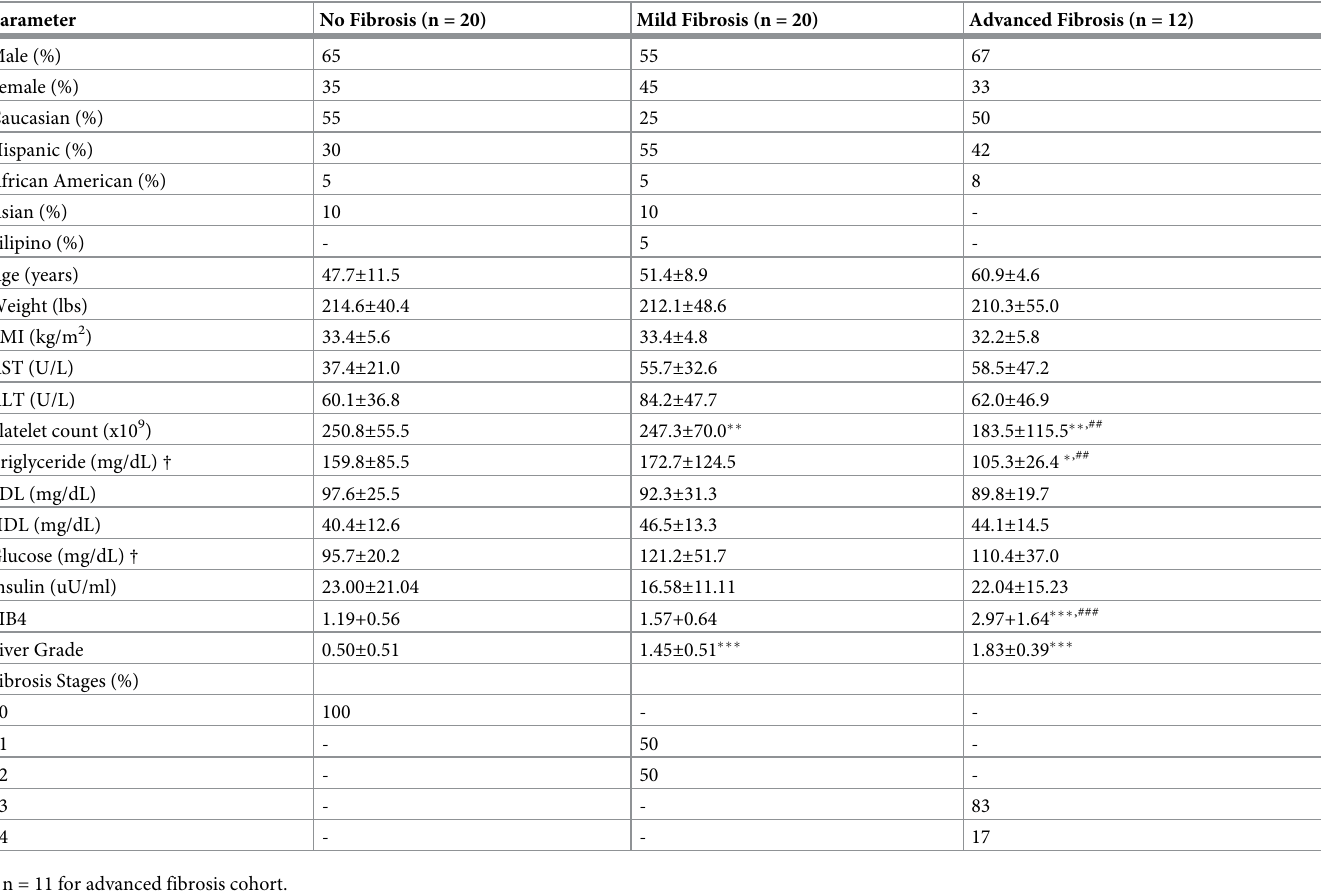
Table 2. Subject